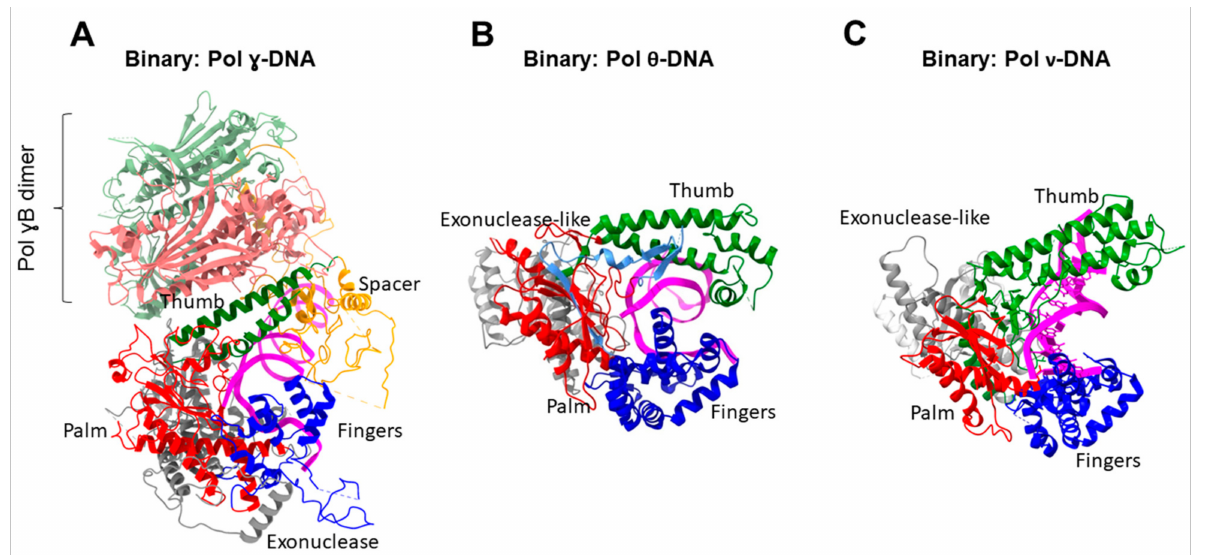
Figure 3. Three-dimensional structure of the binary complex of ( A ) Pol γ (PDB ID 5c52), ( B ) poly- merase domain of Pol θ (PDB ID 4x0p), ( C ) Pol ν (PDB ID 4xvm) with DNA. The thumb (green), palm (red), fingers (blue), and exonuclease (gray) domains are presented. For Pol γ the spacer domain (orange) presents a unique structure. Structure of the heterotrimeric Pol γ holoenzyme contains one catalytic subunit and the Pol γ B dimers (proximal (pink) and distal (light green)